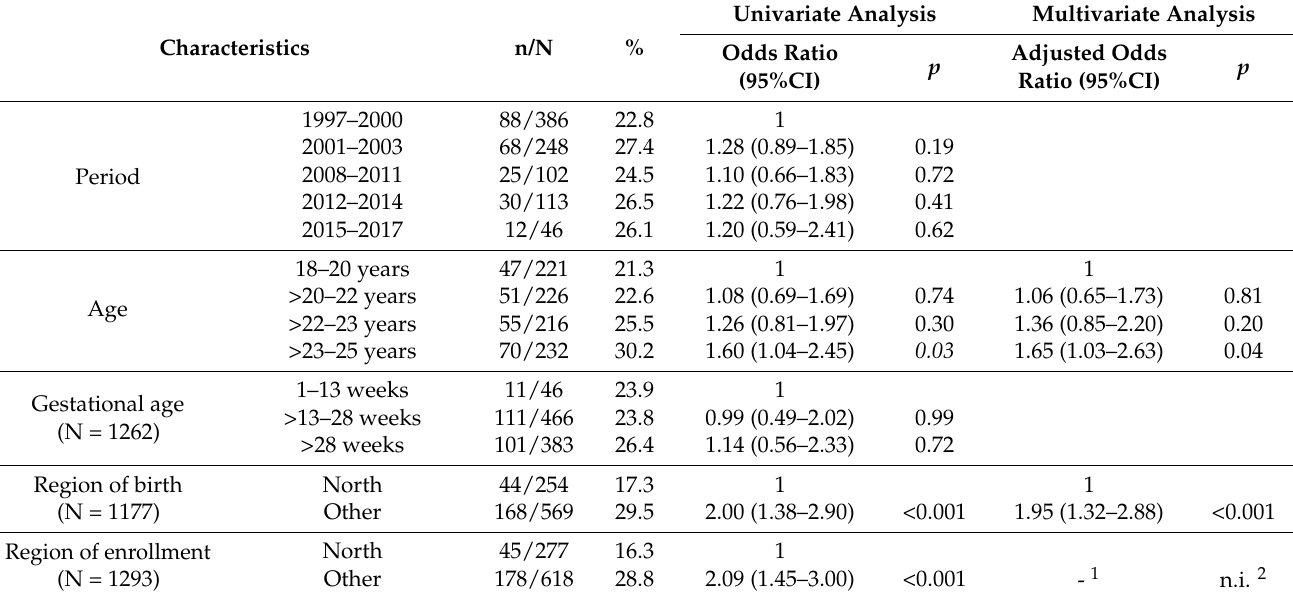
Table 2. Factors associated with ZIKV IgG positivity among pregnant women (N = 1295). Univariate Analysis Multivariate Analysis Characteristics n/N % Odds Ratio